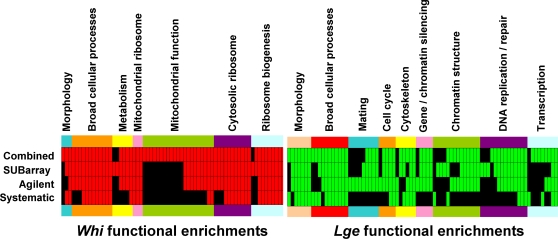
Barcode elutriation and systematic cell size enrichment of gene ontology (GO) annotations.Statistical enrichment from the haploid deletion set was calculated using cumulative hypergeometric probability functions (CDFs) with Bonferroni correction for either the high confidence systematic cell size data; SUBarray or Agilent array data; or the combined set of all whi or lge deletion strains identified. Significant enrichment for whi (red bars) or lge (green bars) strains is defined by [p*N<0.01, where N is the number of categories per subset)]. GO component (N = 330); GO process (N = 1380); Morphology (N = 11) [27]. GO categories are arranged by related function.